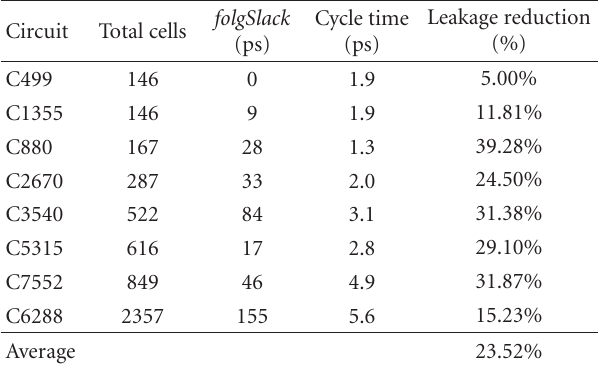
Figure 9: Circuit resulting after the algorithm’s steps. Table 1: Experimental